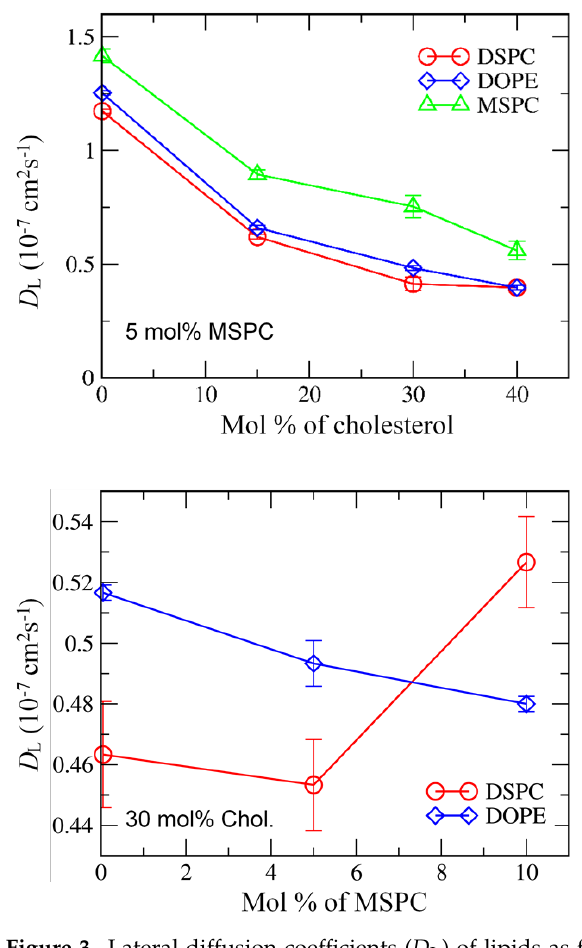
Figure 3. Lateral diffusion coefficients ( D L ) of lipids as functions of cholesterol ( top ) and MSPC ( bottom ) concentrations.